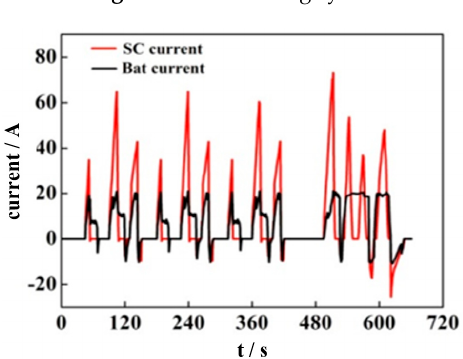
Figure 9. Charge and discharge current distribution of supercapacitors and batteries under the traditional strategy.